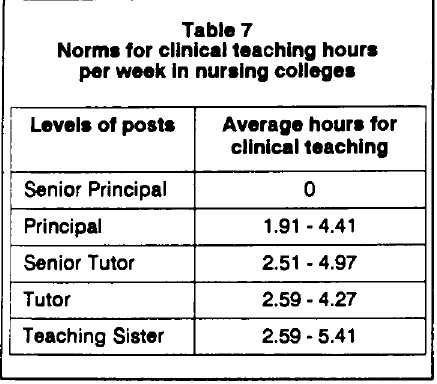
Table 7 Norms for clinical teaching